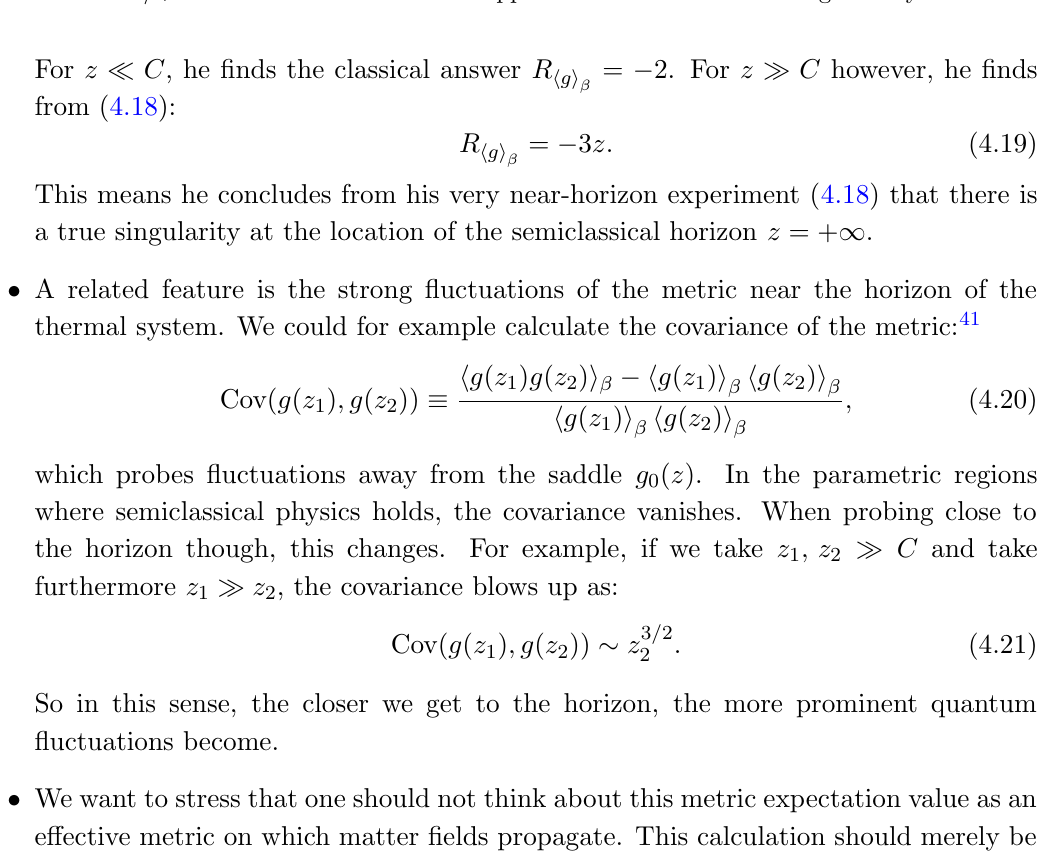
Figure 10 . Bulk geometry as found by our radar definition. Quantum effects become important and deform the effective geometry at a distance of z C , i.e. at the Planck scale (cid:29) P from the ≈ horizon (red). Outside of this region, there is a band (gray) that extends outwards to the black hole scale z C/ √ M that bounds the Rindler approximation to the classical ≈